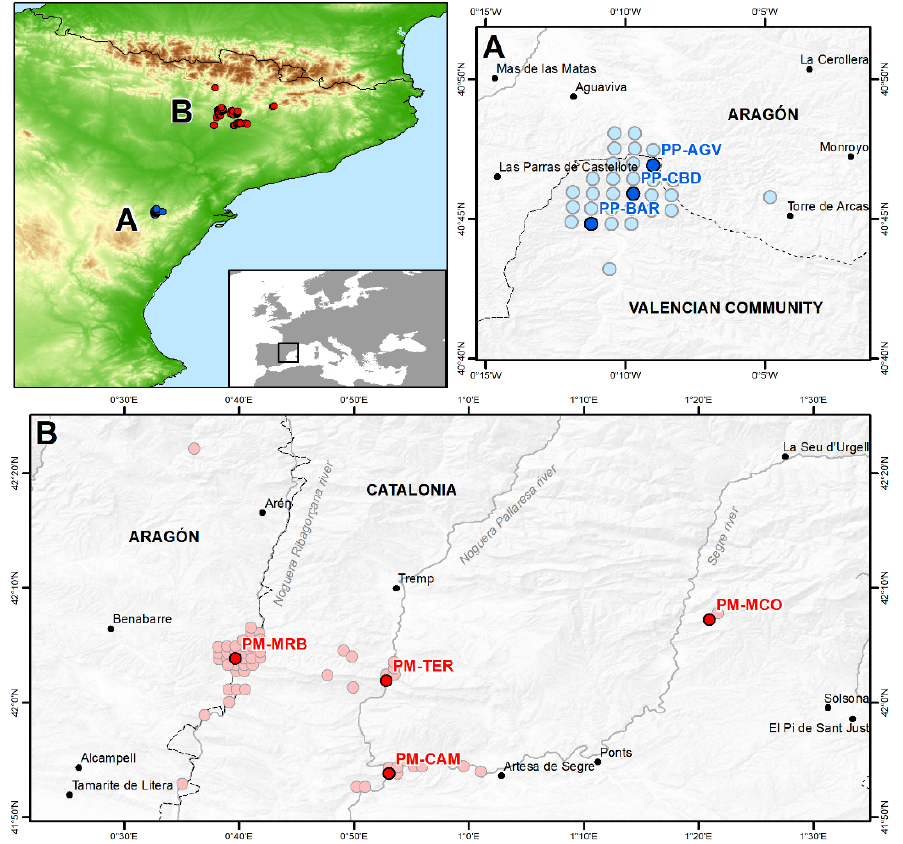
Figure 1. Location of the seven studied populations of the pair Petrocoptis montsicciana (red points)/ P. pardoi (blue points) for the genetic analysis plus the rest of their occurrences used in the niche analysis. ( A ) P. pardoi : PP-AGV, Aiguaviva rocks, Valencian Community, 40 ◦ 47 (cid:48) N, 00 ◦ 09 (cid:48) W, N = 22; PP-BAR, Barranc de la Mare de D é u rocks, Valencian Community, 40 ◦ 44 (cid:48) N, 00 ◦ 11 (cid:48) W, N = 30; PP-CBD, Cantal Badat rocks, Valencian Community, 40 ◦ 46 (cid:48) N, 00 ◦ 10 (cid:48) W, N = 31. ( B ) P. montsicciana : PM-CAM, Camarasa gorges, Catalonia, 41 ◦ 53 (cid:48) N, 00 ◦ 53 (cid:48) E, N = 31; PM-MCO, La M ó ra Comdal rocks, Catalonia, 42 ◦ 07 (cid:48) N, 01 ◦ 21 (cid:48) E, N = 42; PM-MRB, Mont-rebei pass, Catalonia, 42 ◦ 04 (cid:48) N, 00 ◦ 40 (cid:48) E, N = 46; PM-TER, Terradets gorges, Catalonia, 42 ◦ 02 (cid:48) N, 00 ◦ 53 (cid:48) E, N =